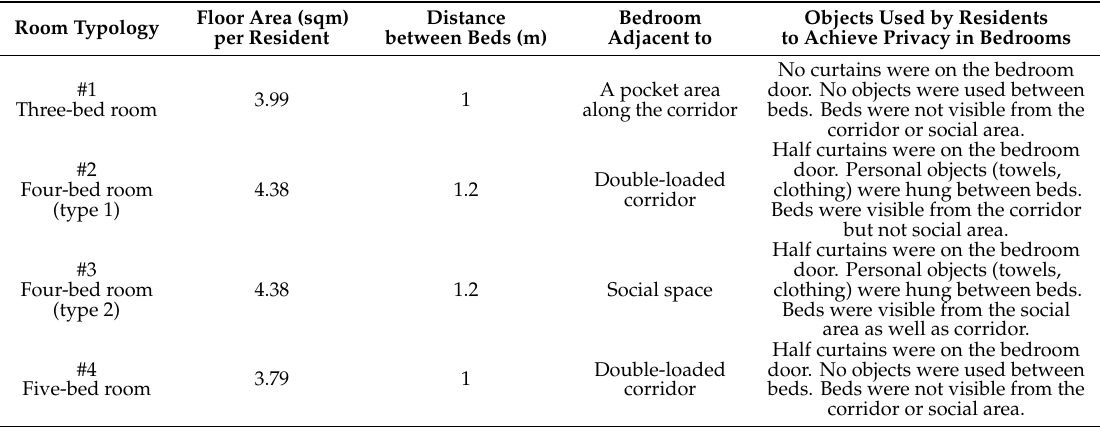
Table 1. Privacy conditions in each room typology and measures taken to maintain privacy.